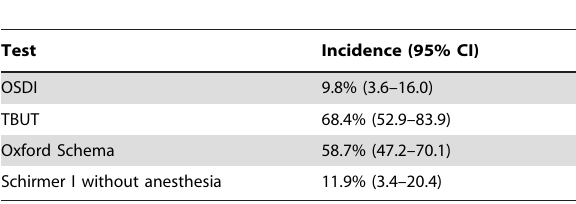
Table 2. Incidence of dry eye at day 7 after phacoemulsification.